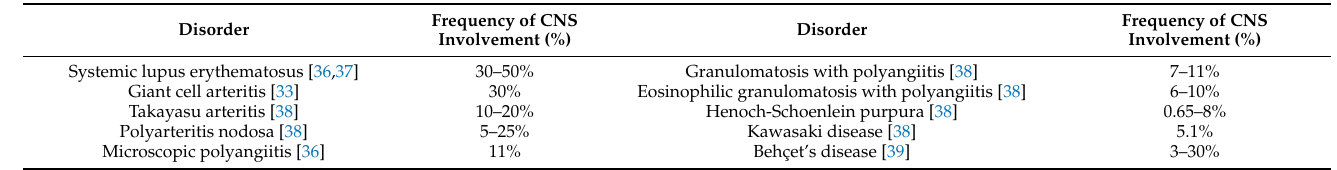
Table 4. CNS involvement in systemic vasculitides.